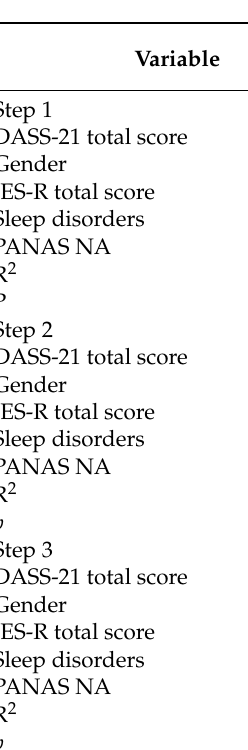
Table 3. Predictors of FBF